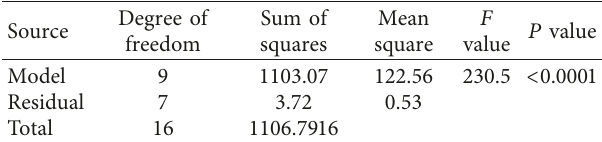
Table 4: Results of ANOVA for the fitted model.